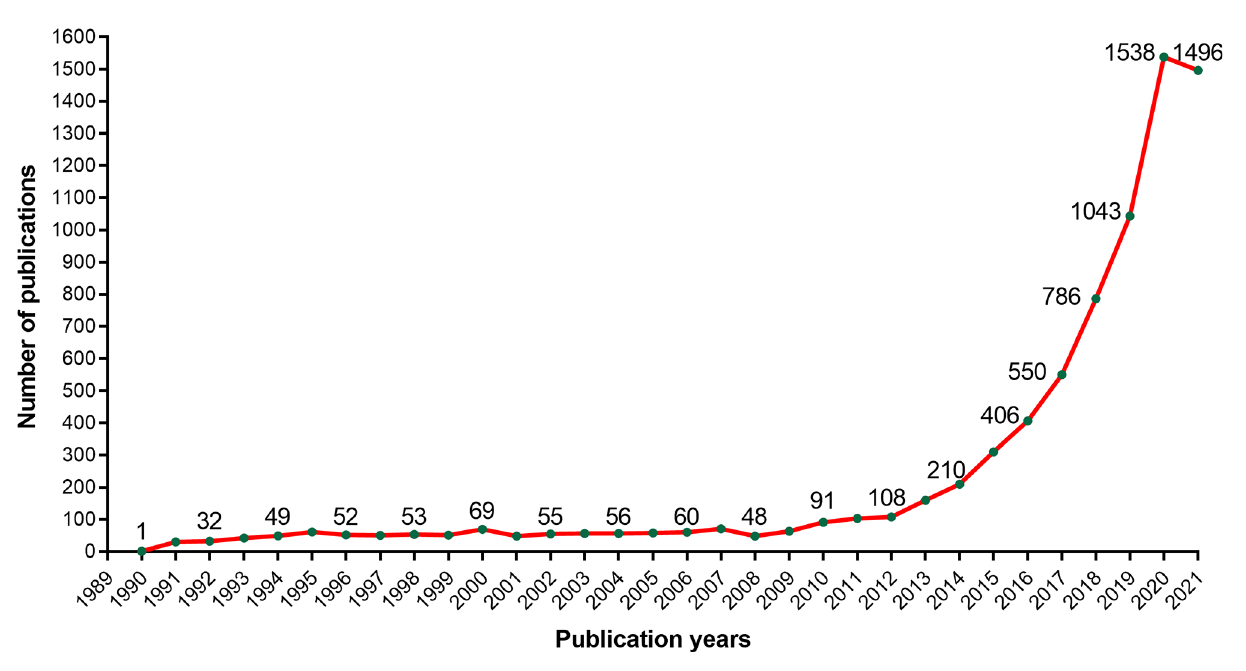
FIGURE 1 | The trend of publication outputs about CAR-T